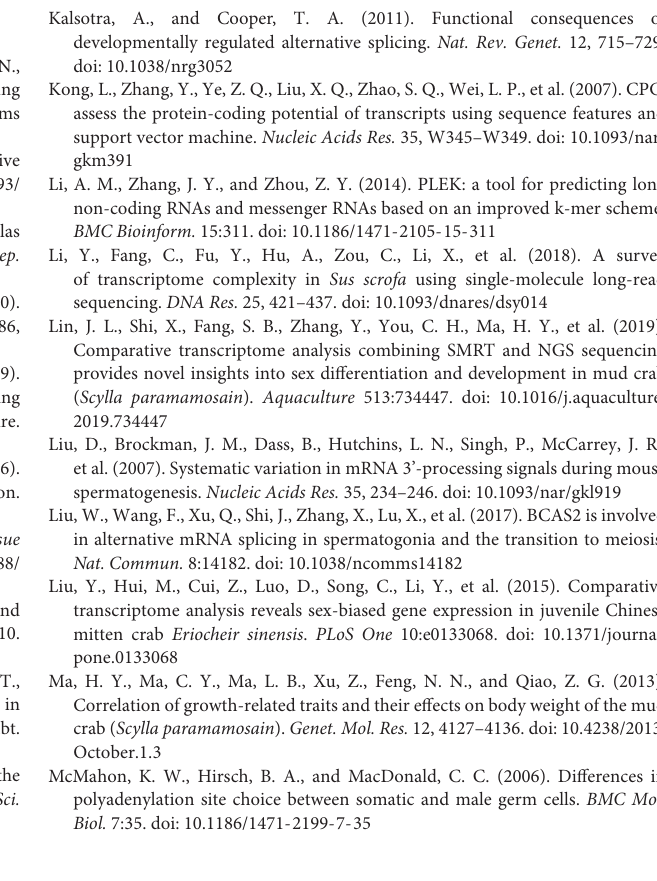
Supplementary Table 2 | Summary of ROIs. Supplementary Table 3 | Summary of the polished consensus sequence. Supplementary Table 4 | Summary of match annotation result. Supplementary Table 5 | CDS types classification of prediction using ANGEL. Supplementary Table 6 | The number of gene